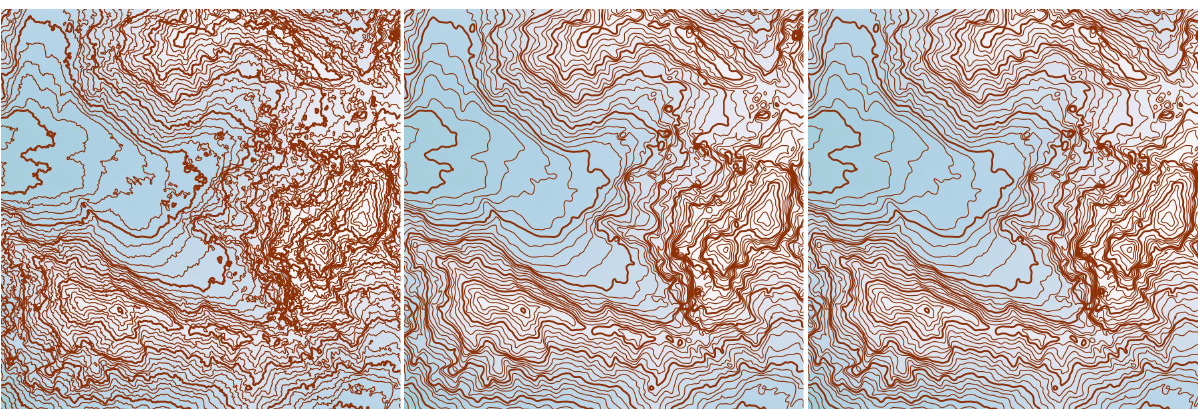
Figure 5. Exemplary result of contour line derivation around the two Ushba peaks (right centre) and the Ushba Glacier. From left: unmodified DSM, multiple low-pass filtered DSM, smoothed using polynomial method. Scale 1:80,000, equidistance 50m.